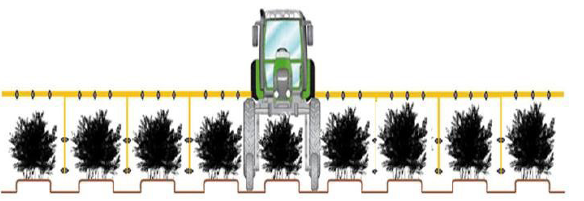
Figure 1. The scheme of the tractor-sprayer assembly used in the experiment. Notice the horizontal spray boom, the droplegs, and the nozzles